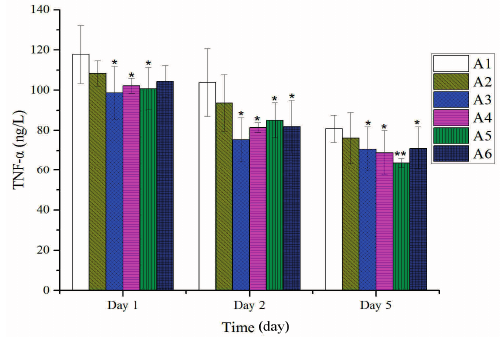
Figure 5. Effect of different concentrations or fractions of BBO on plasma TNF- α in rats. Values are expressed as mean ± S.D. ( n = 4 animals). * : p < 0.05 vs. control; ** : p < 0.01 vs.